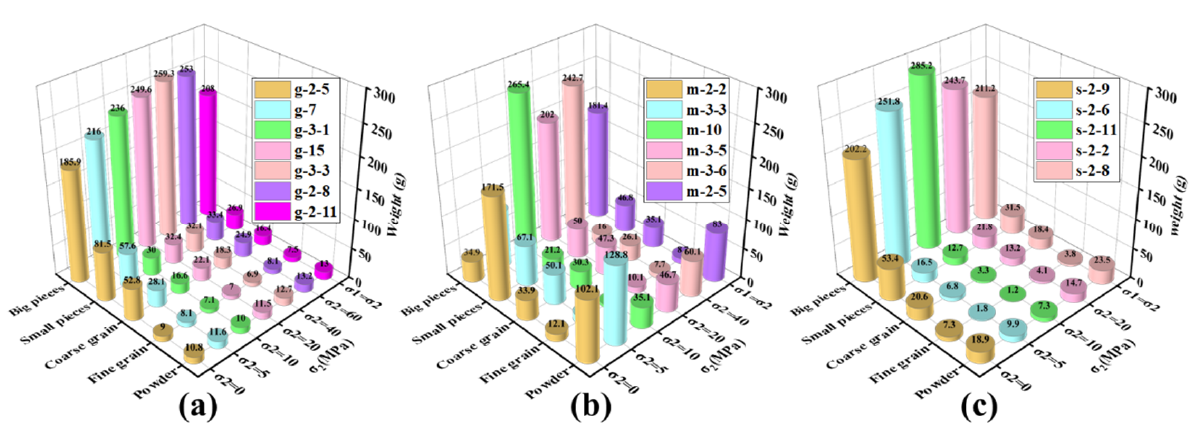
Figure 15. Weight of fragments with different sizes: ( a ) granite, ( b ) marble, and ( c ) sandstone.